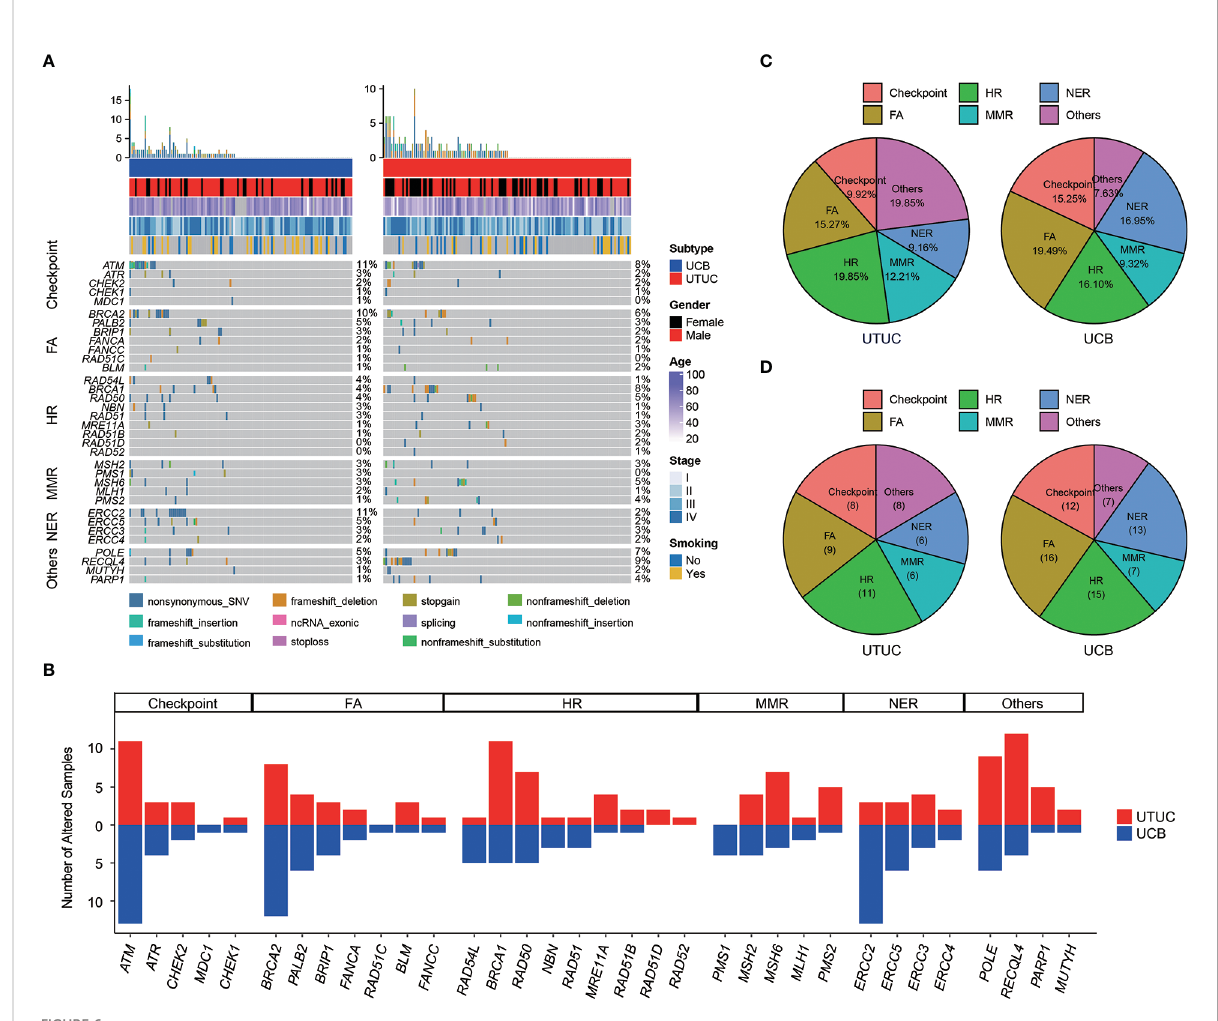
FIGURE 6 Differences in the prevalence of DDR related genes/pathways between Chinese UTUC and UCB. (A) Comparison of prevalent alterations in thirty-four DDR related genes between Chinese UTUC and UCB. (B) Number of UTUC and UCB patients harboring at least one alteration in six DDR-related canonical pathways of Checkpoint, FA, HR, MMR, NER, and Others. (C) Comparison of the differences in the prevalence of altered DDR-related pathways between UTUC and UCB. (D) Comparison of the differences in the prevalence of deleterious/likely deleterious alterations in DDR related pathways between UTUC and UCB. UTUC, upper tract urothelial carcinoma; UCB, urothelial carcinoma of the bladder; DDR, DNA damage repair; FA, Fanconi Anemia; HR, Homologous Recombination; MMR, Mismatch Repair; NER, Nucleotide Excision